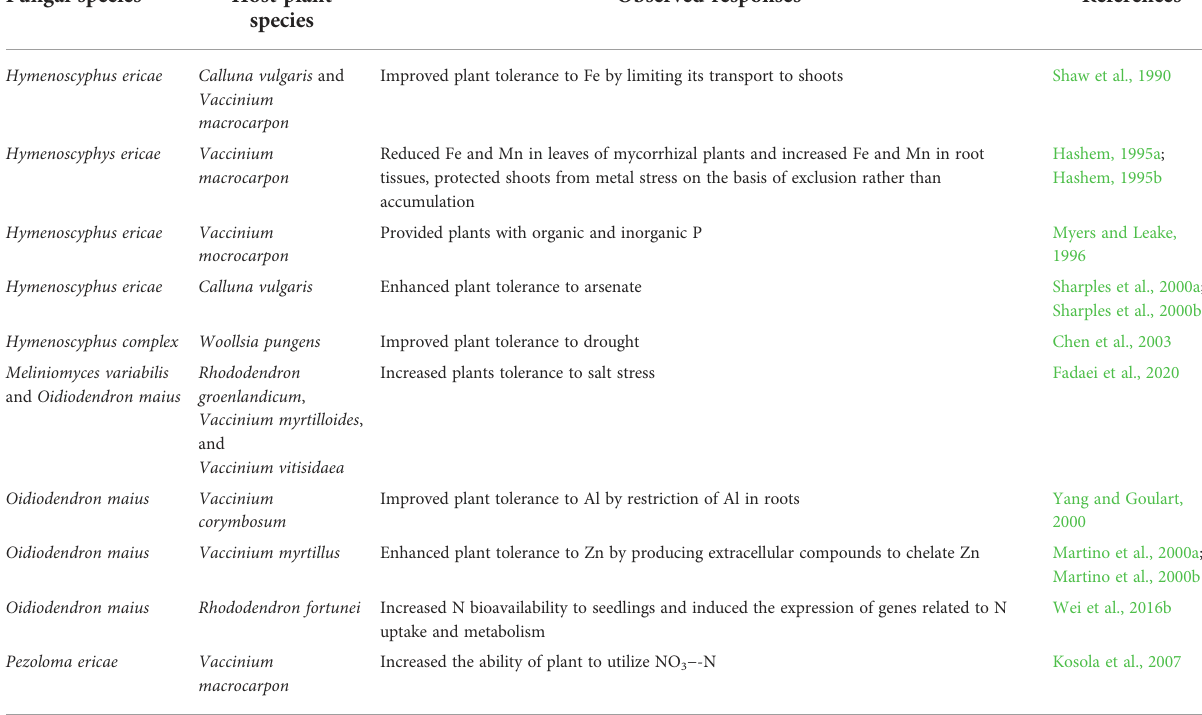
TABLE 4 Ericoid mycorrhizal fungi improve plant tolerance to abiotic stresses. Fungal species Host plant